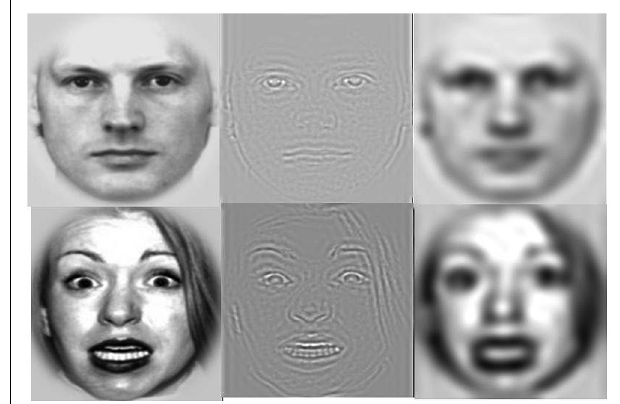
FIGURE 2 | Example stimuli from Park etal. (2012b). Normal broad spatial frequency (BSF) fearful and neutral faces (left column), high spatial frequency (HSF) faces (middle column), and low spatial frequency (LSF) faces (right